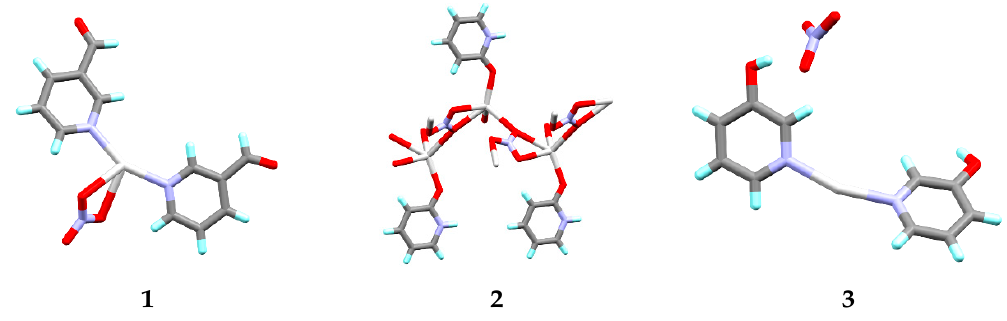
Figure 2. The X-ray structure of complexes 1 – 3 .